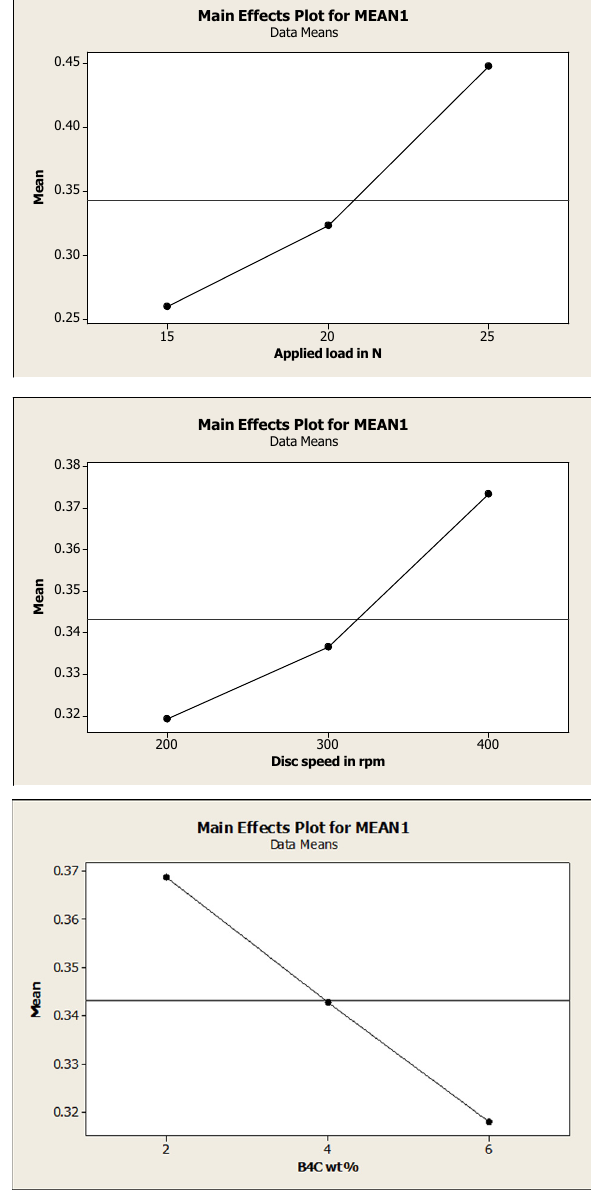
Figure 9: Main e ff ect plot of means of applied load, disc speed, and B 4 C